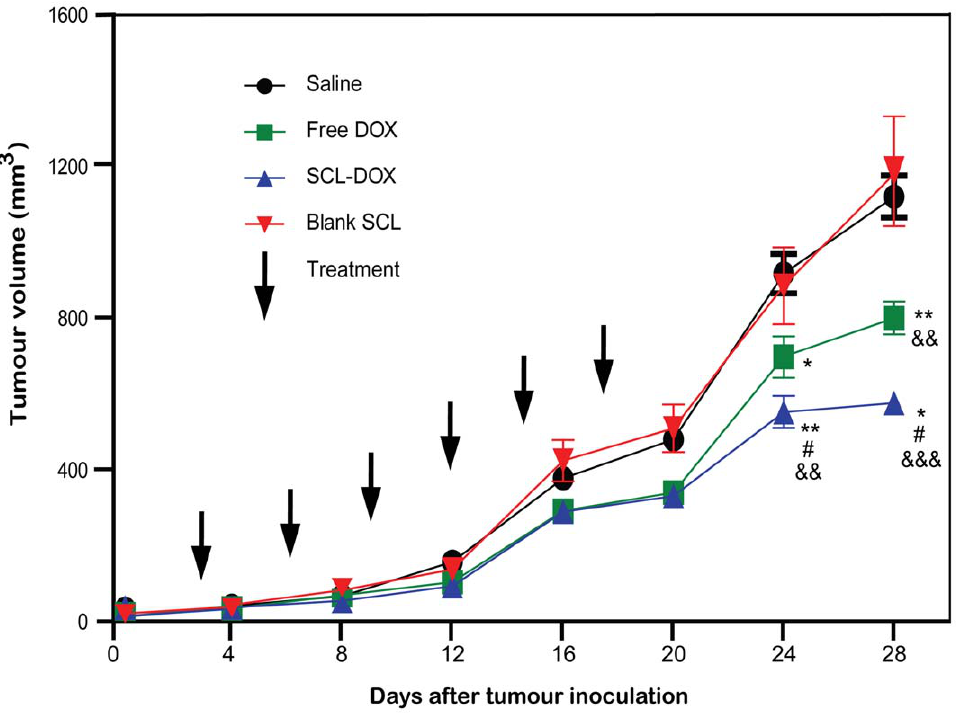
Figure 4. Sulfatide-containing liposomal doxorubicin produced more reduction in tumor volume. Mice bearing HT-29 xenografts were injected i.v. with saline, 5 mg/kg of free DOX, SCL-DOX or empty SCL twice a week for 3 weeks as indicated, starting on the day when tumor volume reached , 35 mm 3 . Data shown are means 6 S.E. (n=5 , 6). *, P , 0.05 compared to saline; **, P , 0.01 compared to saline; # , P , 0.05 compared to free DOX; &&, P , 0.01 compared to blank SCL; &&&, P , 0.001 compared to blank SCL.